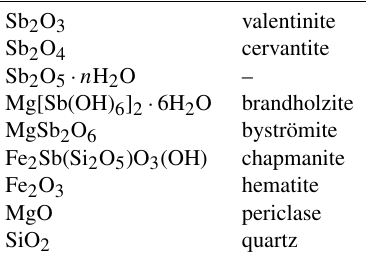
Table 1. Chemical formulae and mineral names of phases investi- gated in this work. With the exception of chapmanite, all samples used in this work were synthetic. Space groups and refined lattice parameters for the antimony phases can be found in Table